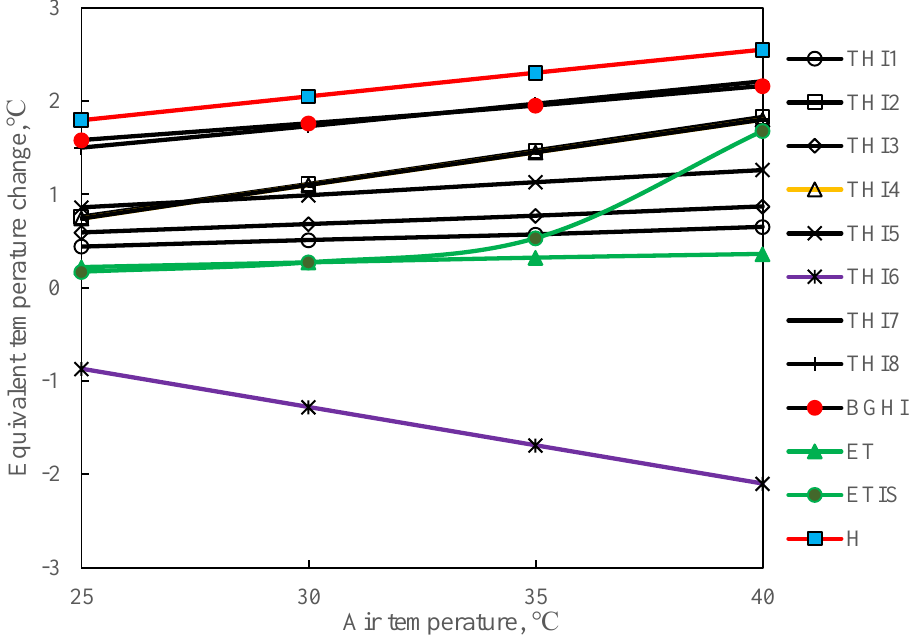
Figure 2. Equivalent temperature change. To calculate the equivalent air temperature (T equ ) change of the other parameters, e.g., relative humidity changes, the heat index is held constant in the calculating process. In this comparison, the air velocity of effective temperature and equivalent temperature index of sows is set as 1 m·s − 1 . THI is the temperature and humidity index. The numbers 1–8 after THI represent different forms of THI, which are shown in Table 1. BGHI is black globe-humidity index. Et is effective temperature, ETIS is equivalent temperature index of sows. H is enthalpy.